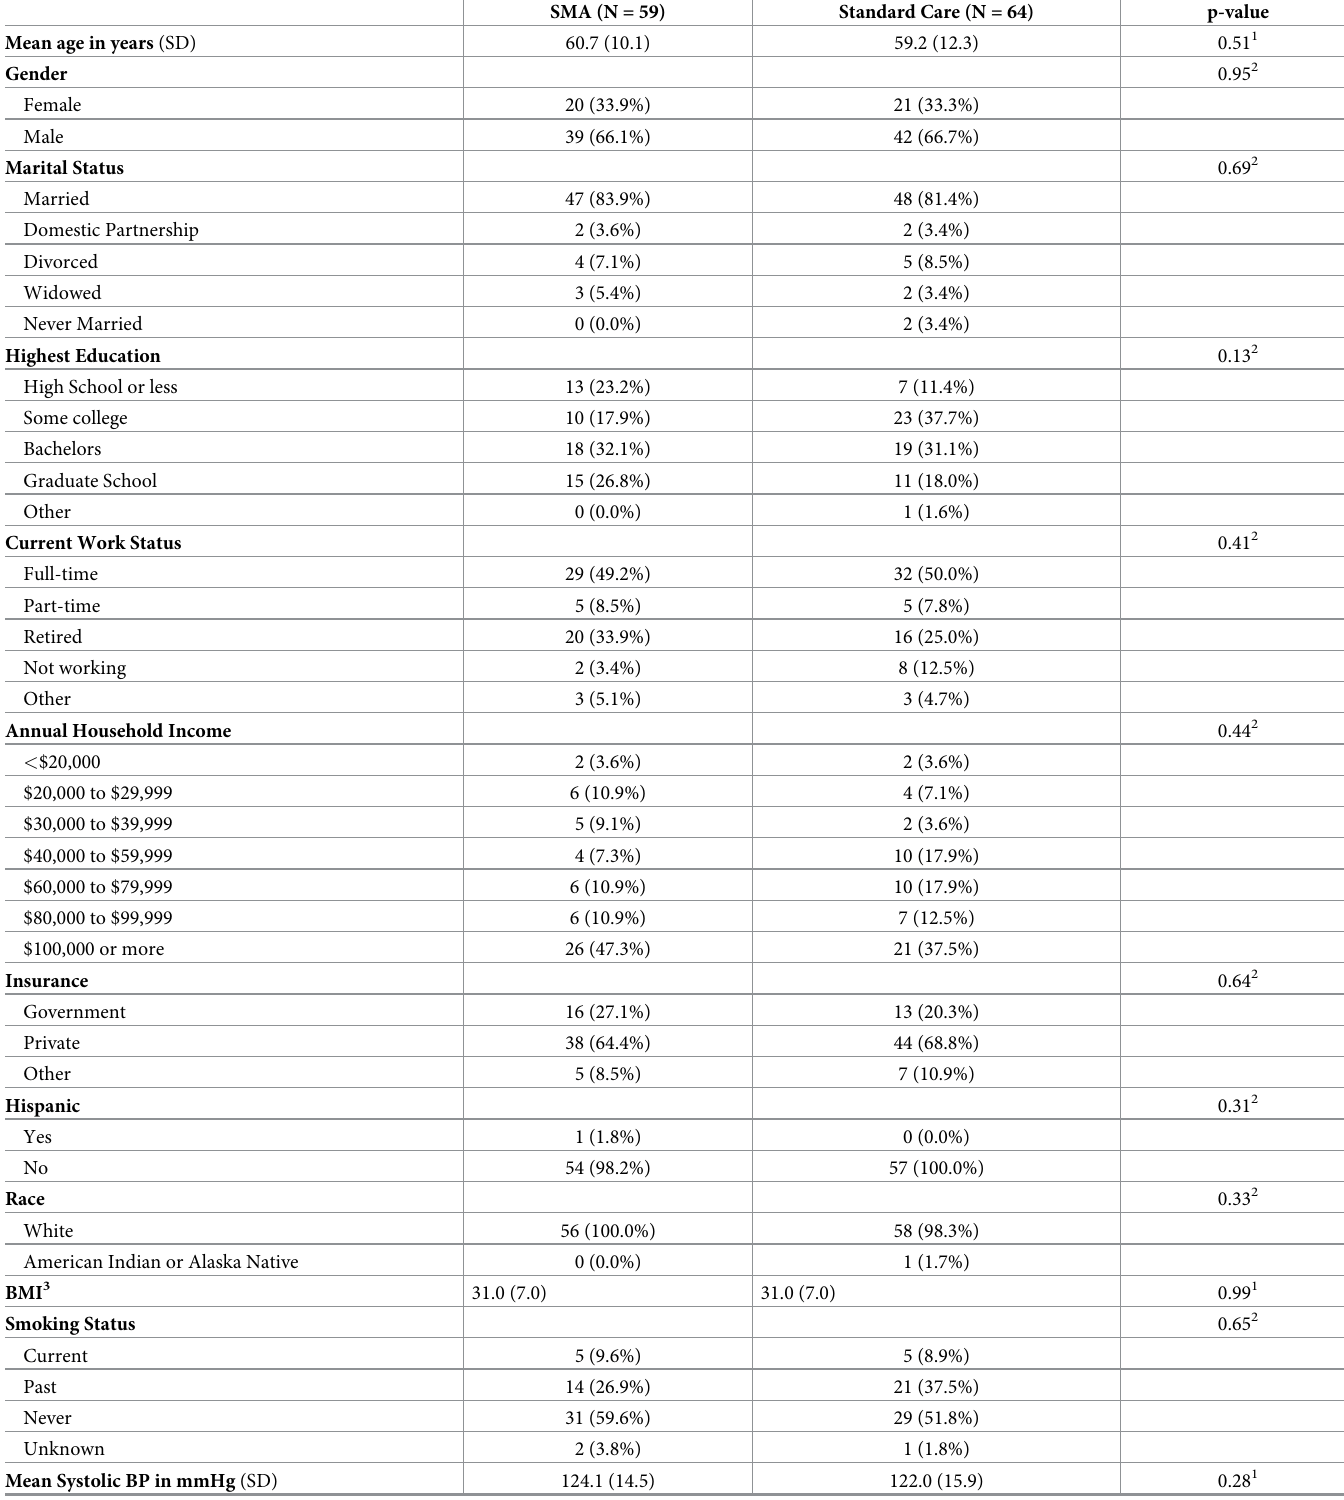
Table 3. Demographic and clinical characteristics of the sample N =